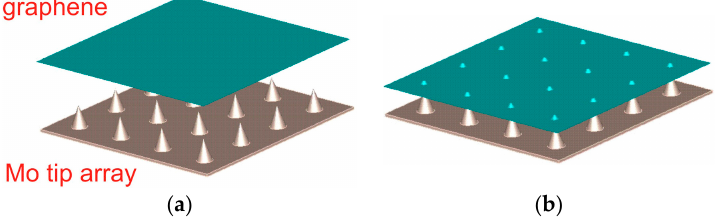
Figure 1. Schematic of the graphene-coated Mo tip array ( a ) before and ( b ) after transfer of the graphene-coated layer.